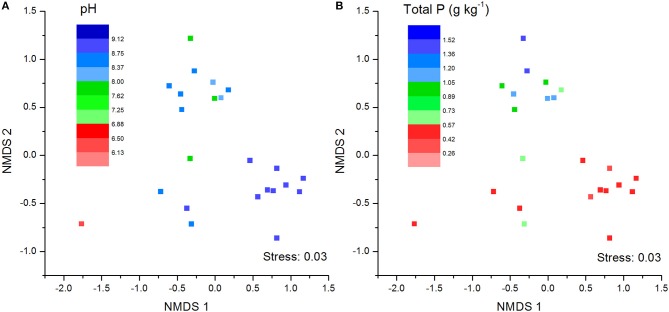
Soil bacterial community structure as indicated by unweighted no-metric multi-dimensional scaling plots (NMDS) of pairwise UniFrac community distance across sites. Sampling sites have been color-coded by pH values (A) and total phosphorus content (B).